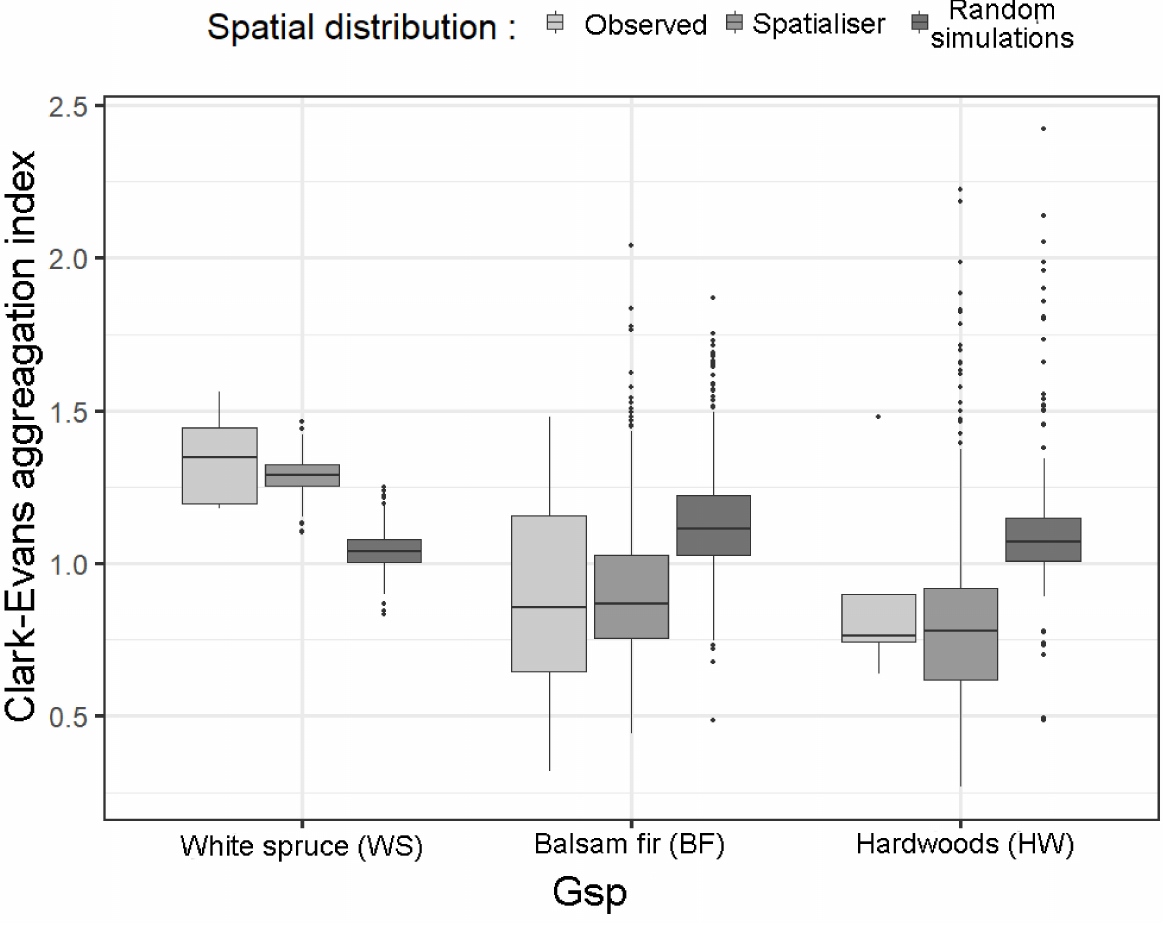
Figure 4. Comparison between Clark and Evans indexes observed for the 3 species groups (Gsp: see Table 2 for definitions) and the indexes predicted from the “spatialiser” simulations and from random simulations.